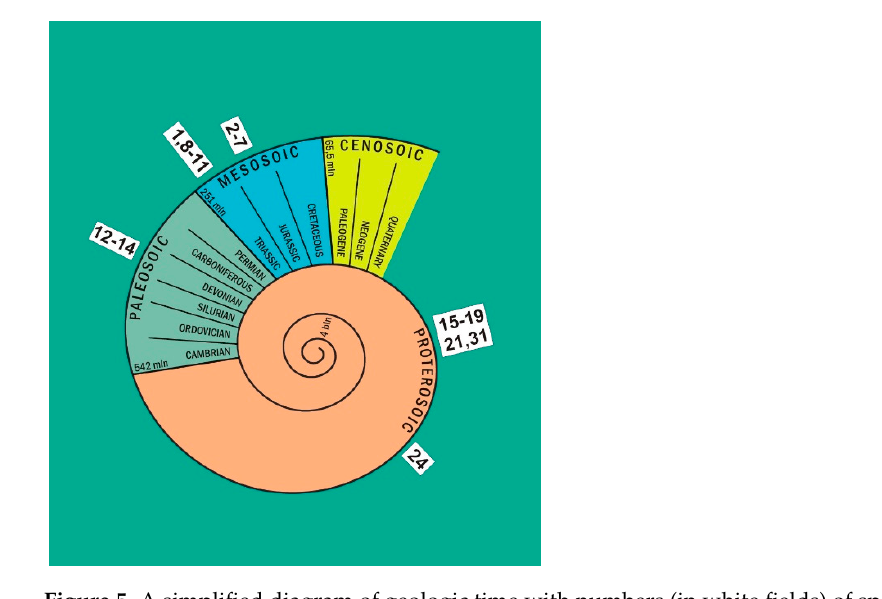
Figure 4. A simplified map of the Kielce region. Sites of specimen collection and the ice-sheet ex- tent during the Odranian Middle-Polish Glaciation MIS (marine isotope stage) 6 according to [2] are marked.